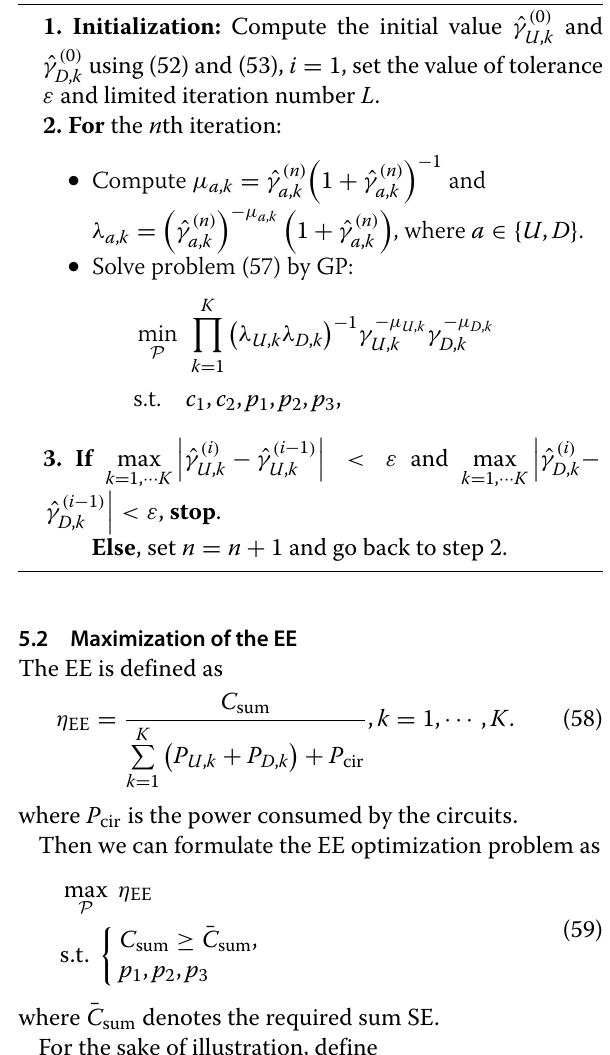
Algorithm 1 Solving problem (57) by